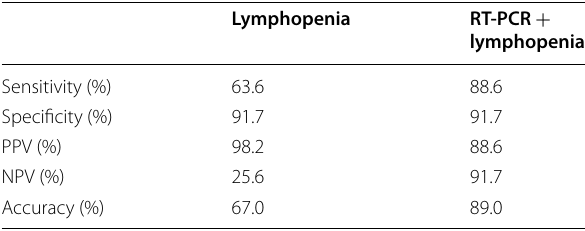
Table 5 Performance characteristics of PCR and lymphopenia in relation to CT chest